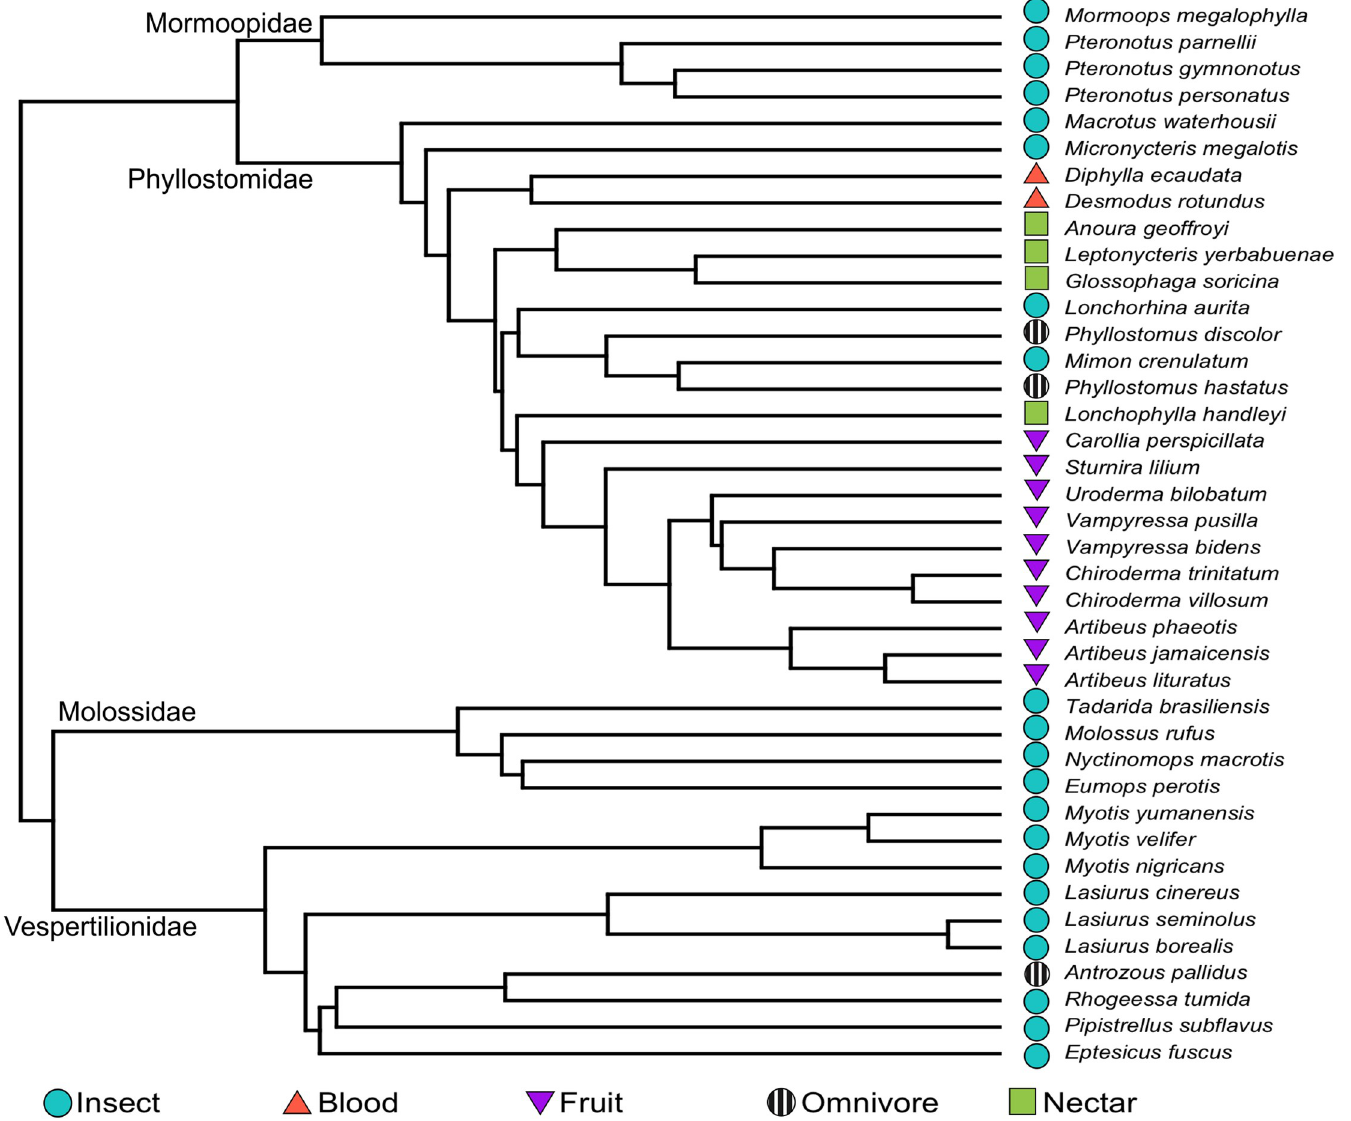
Fig 3. Phylogenetic tree used for phylogenetic comparative methods. Tree is derived from the species-level phylogeny of Shi and Rabosky [43] and pruned to include only species examined in this study. Symbols represent diet categories.